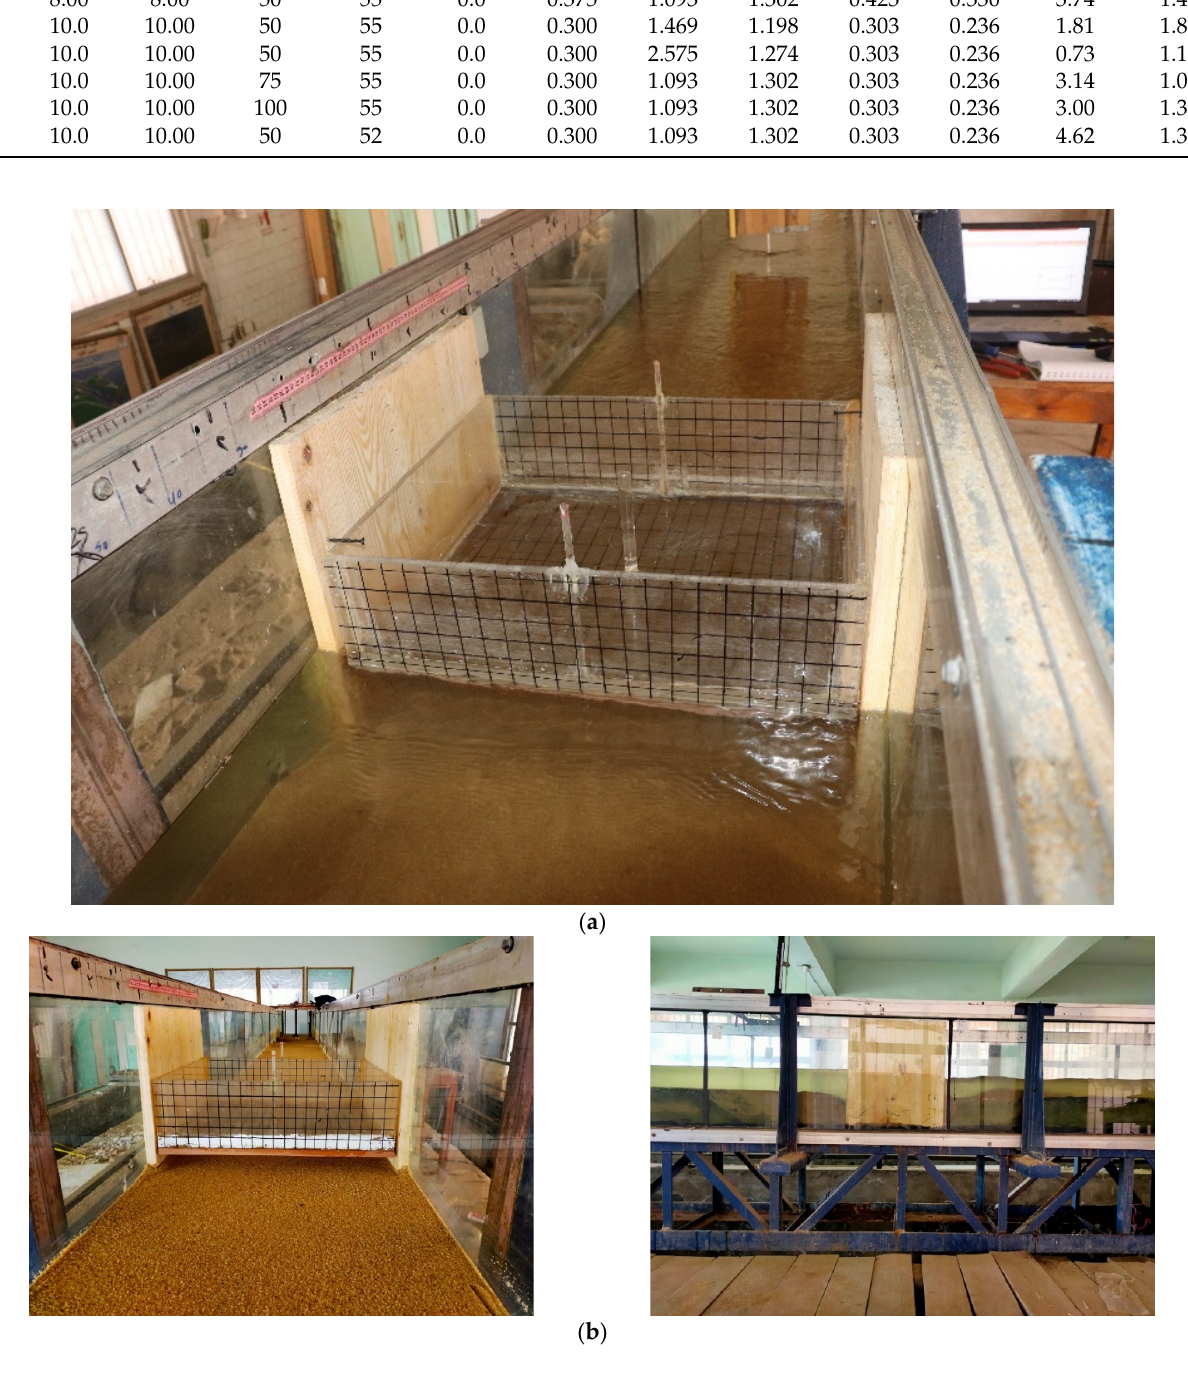
Figure 1. Experimental apparatus: ( a ) bridge deck and vertical wall abutments; ( b ) elevation and side view.